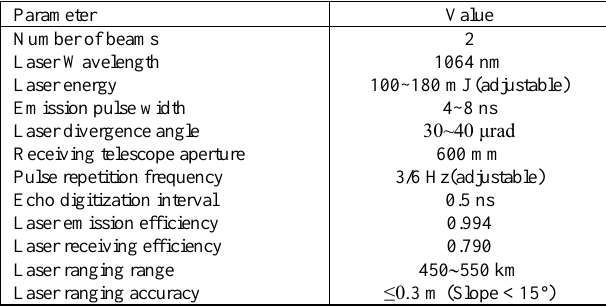
Table 1. Basic parameters of the GF-7 laser altimeter